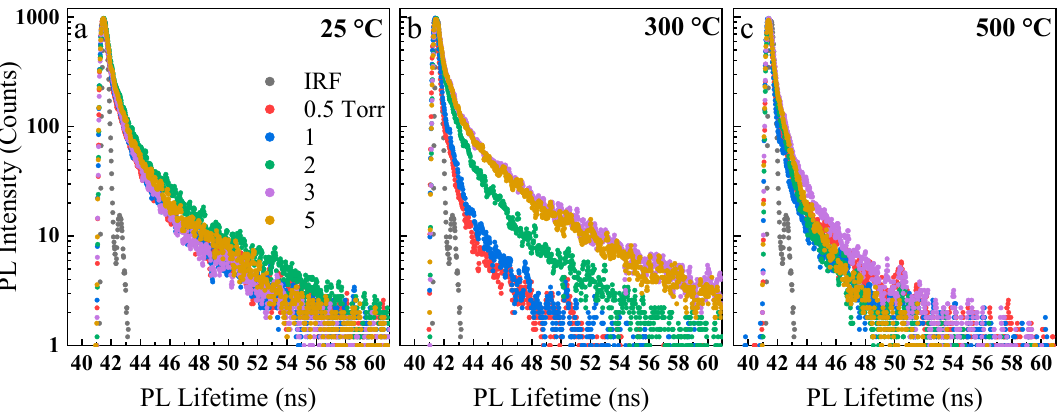
Figure 6. PL lifetime of the nanoparticles deposited at various pressure and heat-treated at different temperatures, including the as-deposited ( a ), 300 °C ( b ), and 500 °C ( c ). The overall trend shows that the PL lifetime increases as the deposition pressure increases.